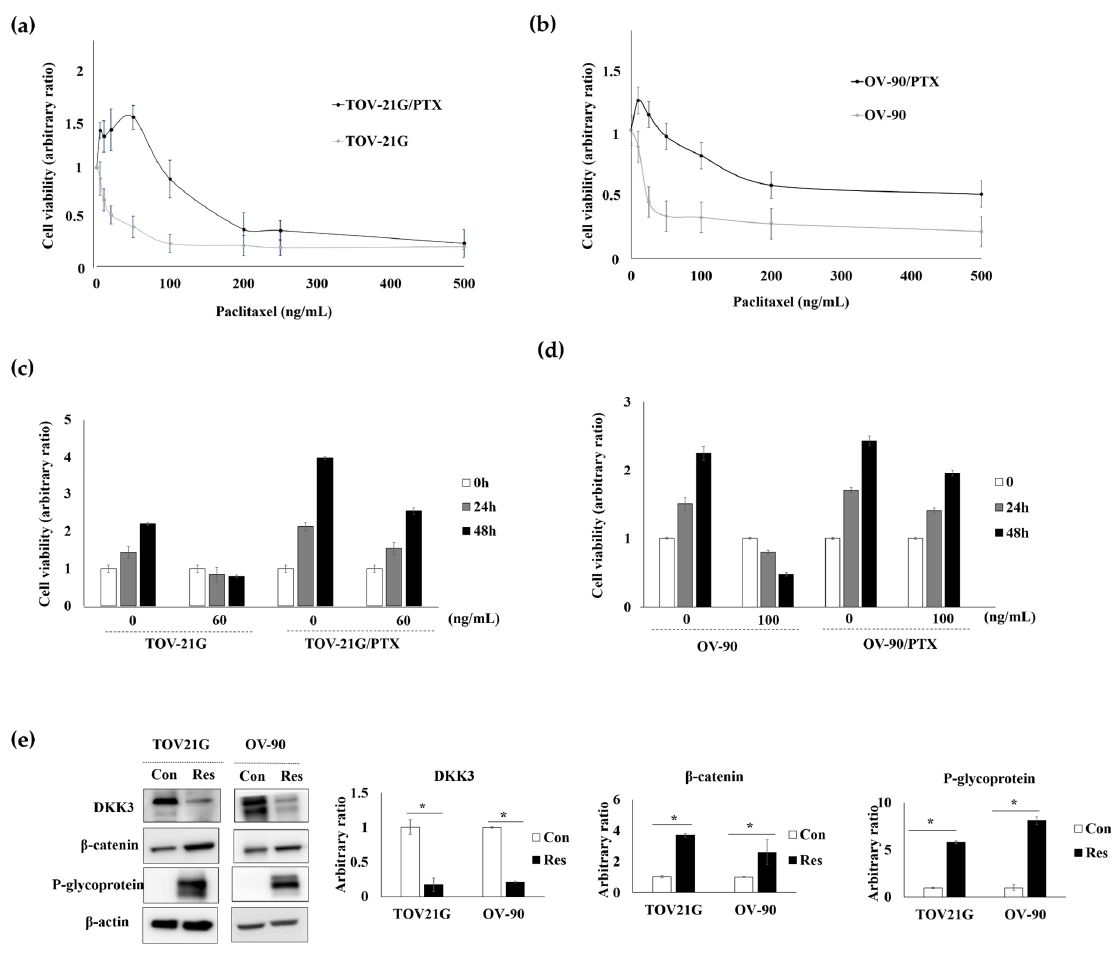
Figure 2. Characteristics of paclitaxel-resistant cells. ( a , b ) Cells were seeded in triplicates in 96-well plates in 0.1 mL culture medium at a density of 1 × 10 4 cells/well. After 24 h, the cells were treated with paclitaxel. MTT assay performed 48 h after treatment showed that the paclitaxel-resistant cells (TOV-21G/PTX and OV-90/PTX) had higher IC 50 than the parental cells. ( c , d ) Paclitaxel treatment reduced the viability of parental cells, while the paclitaxel-resistant cells continued to grow. ( e ) Western blot analysis revealed that DKK3 was lost and that β -catenin and P-glycoprotein were upregulated in paclitaxel-resistant cells (Res) compared to that in their parent cells (Con). β -Actin was used as the loading control. * p < 0.01.